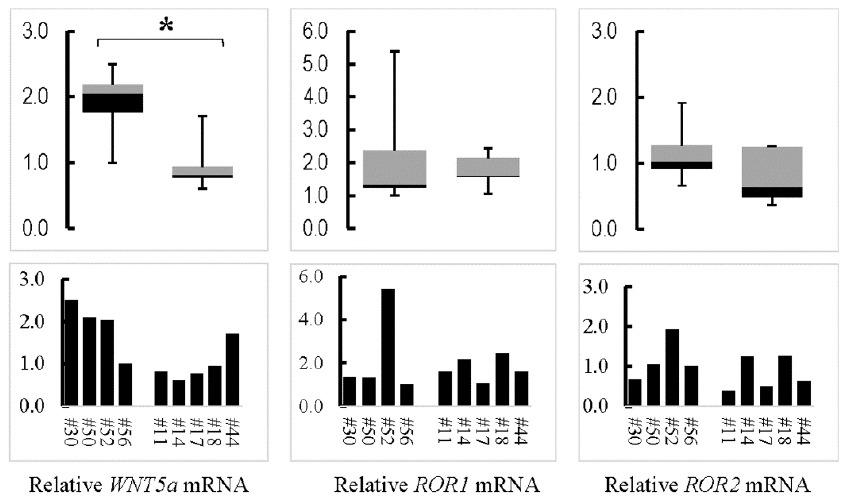
Figure 8. Expression of WNT5a, ROR1 and ROR2 in human bronchopulmonary dysplasia (BPD) lungs. Human lung samples from deceased donors were collected and processed at the University of Rochester following the protocol approved by University of Rochester Institutional Review Board. Relative mRNA for the examined genes is presented in a 2-D column chart with levels of #56 arbitrarily set as “1”. Data distribution of the non-BPD (#30, #50, #52, #56) and the BPD (#11, #14, #17, #18, #44) samples is shown by the boxplot. * indicates p < 0.05.